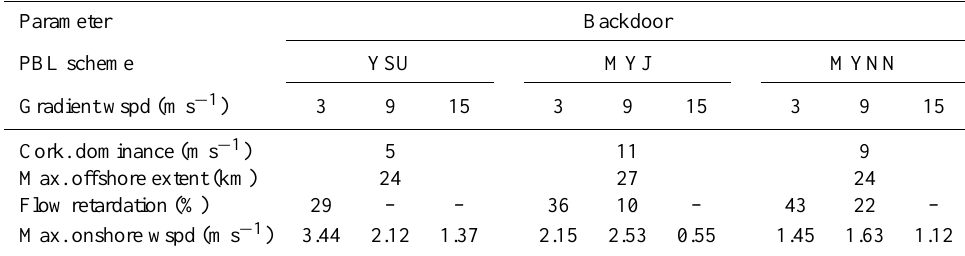
Flow retardation (%)